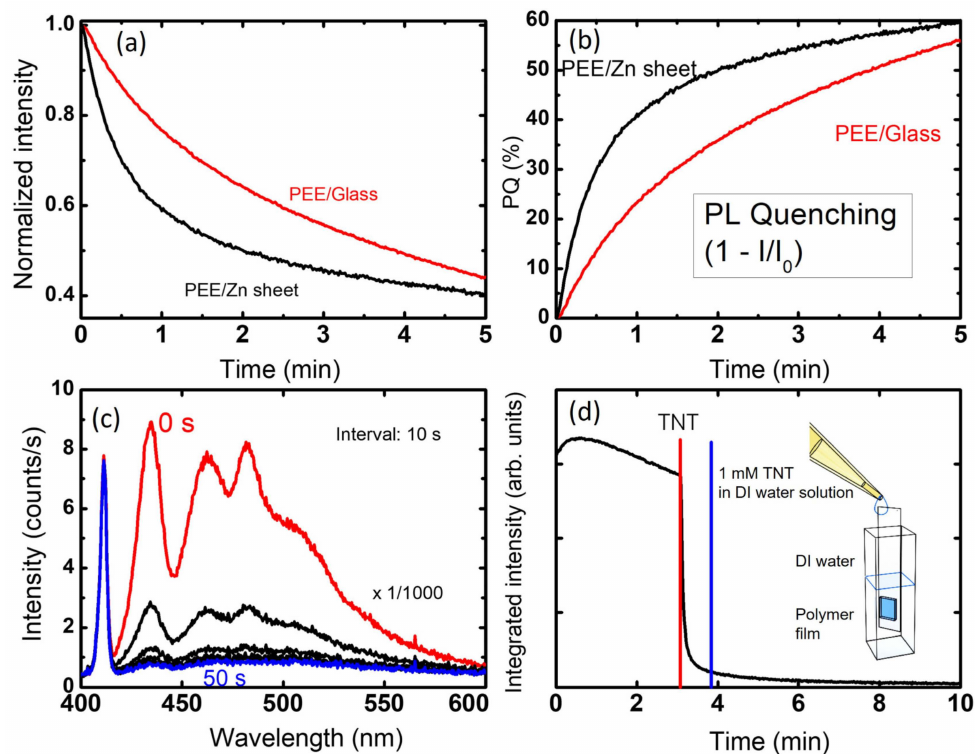
Figure 4. ( a ) Time-dependent integrated PL intensity of PEE films deposited on glass and on Zn sheet when exposed to TNT vapor at a flow rate of 6 L/min. ( b ) PL quenching curves of PEE films by TNT vapor as a function of time. ( c ) The change in the PL spectra observed with a glass/PEE film, which was initially placed in a transparent glass cuvette containing DI water. When 1 mM aqueous TNT solution was added, PL quenching was observed. ( d ) Time-dependent integrated intensity curve of PEE film deposited on glass and placed in aqueous solution. The arrow in the figure indicates the time when the TNT solution was added. A schematic diagram of the experimental set-up is shown in the